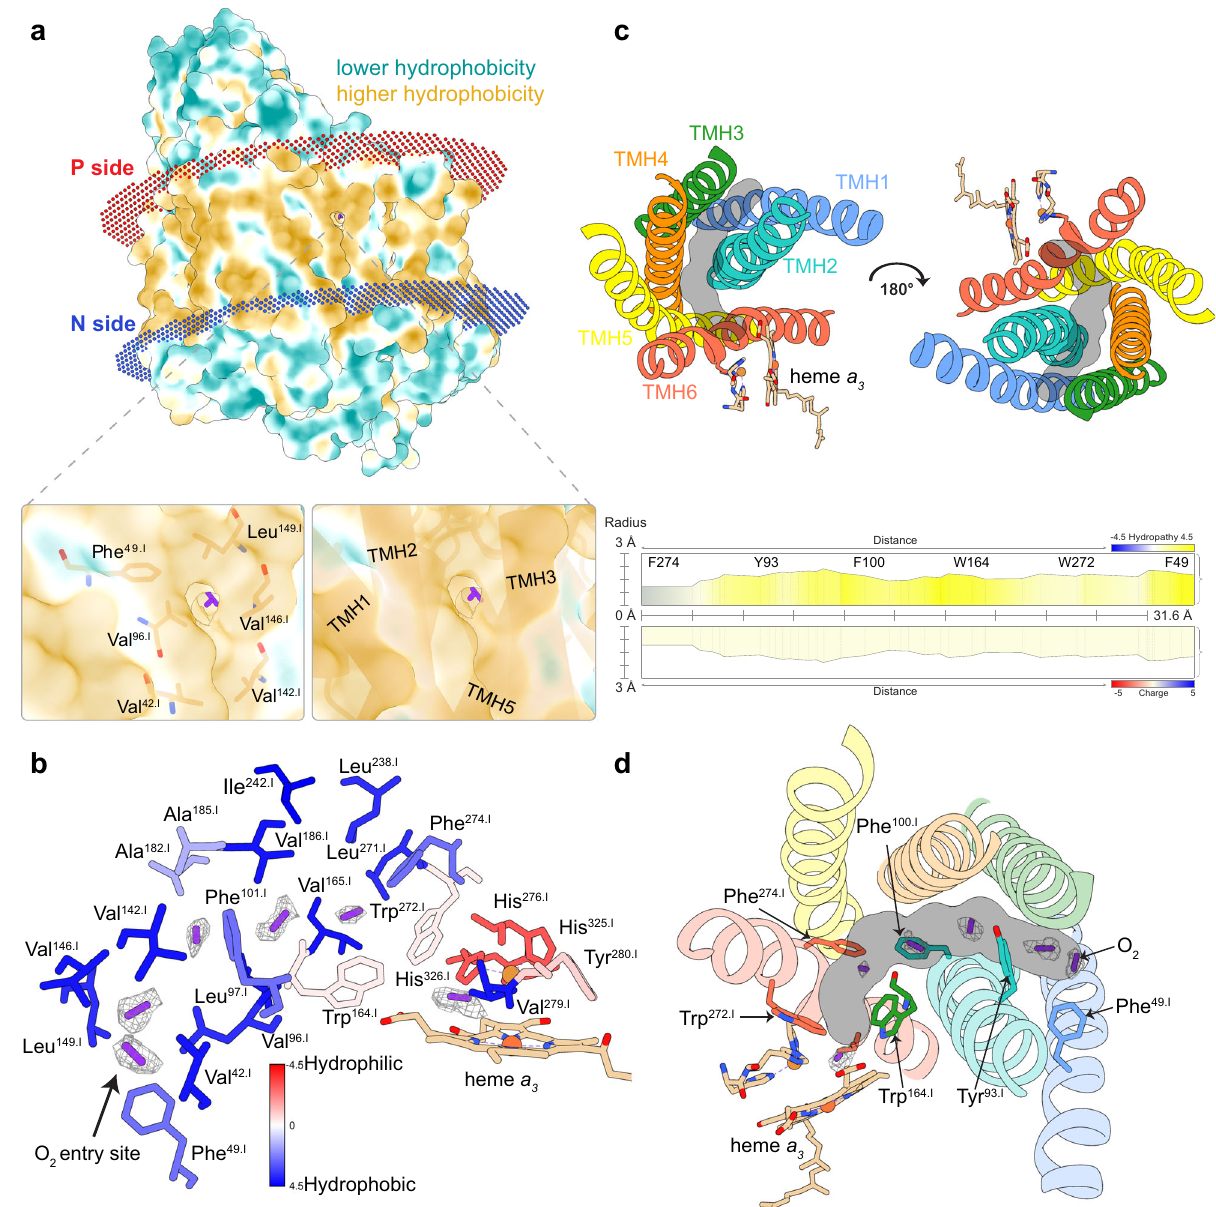
Fig. 3 Oxygen entry site and channel composition. a Surface representation of C c O and its oxygen entry point located between the transmembrane helix (TMH) 1 and 3 in the hydrophobic transmembrane site. The illustrated map density is fi ltered to a contour level of 2. b Detailed composition of the oxygen- conducting channel based on their hydrophobicity. The illustrated map density is fi ltered to a contour level of 0.5. c Interior channel embedded in between six transmembrane helices and channel lining residues predicted by Mole 2.5. d Overlay of channel prediction and individually displayed lining residues with corresponding dioxygen densities. Dioxygen molecules are shown as purple sticks, the corresponding densities are highlighted by mesh